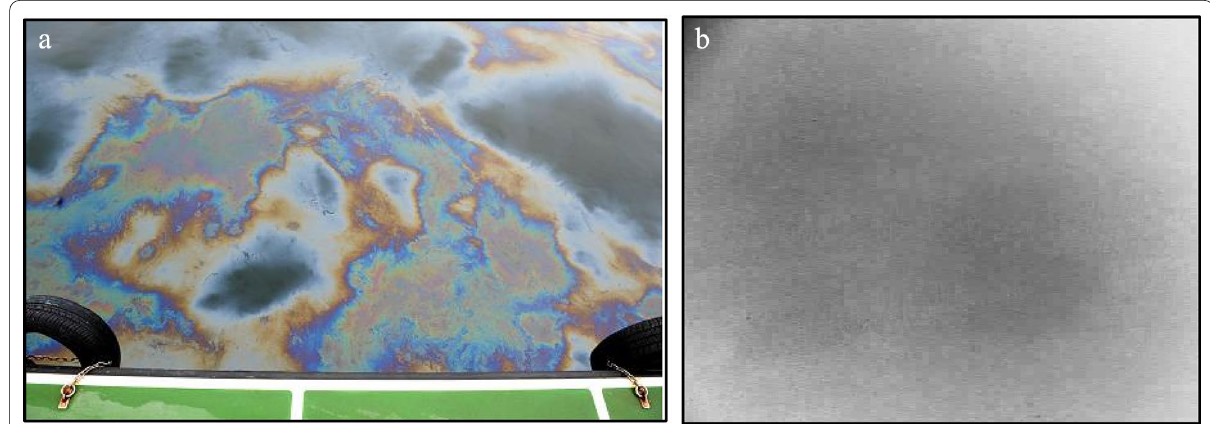
Fig. 11 Oil spill auxiliary identification methods of shipborne radar. a The oil films during the daytime was photographed on July 19, 2010. b Infrared image of sea surface at night of 716 oil spill accident